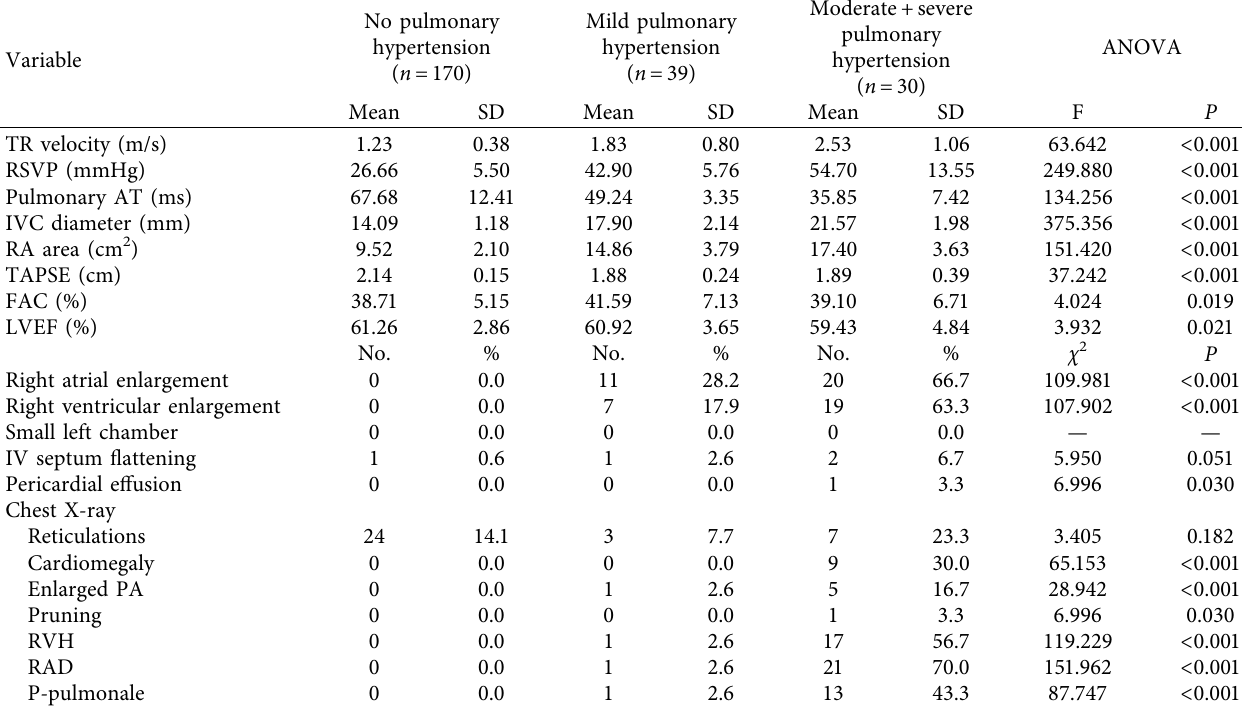
Table 7: Association of pulmonary hypertension (mPAP ≥ 25mmHg) and transthoracic echocardiography, ECG, and chest radiograph findings.